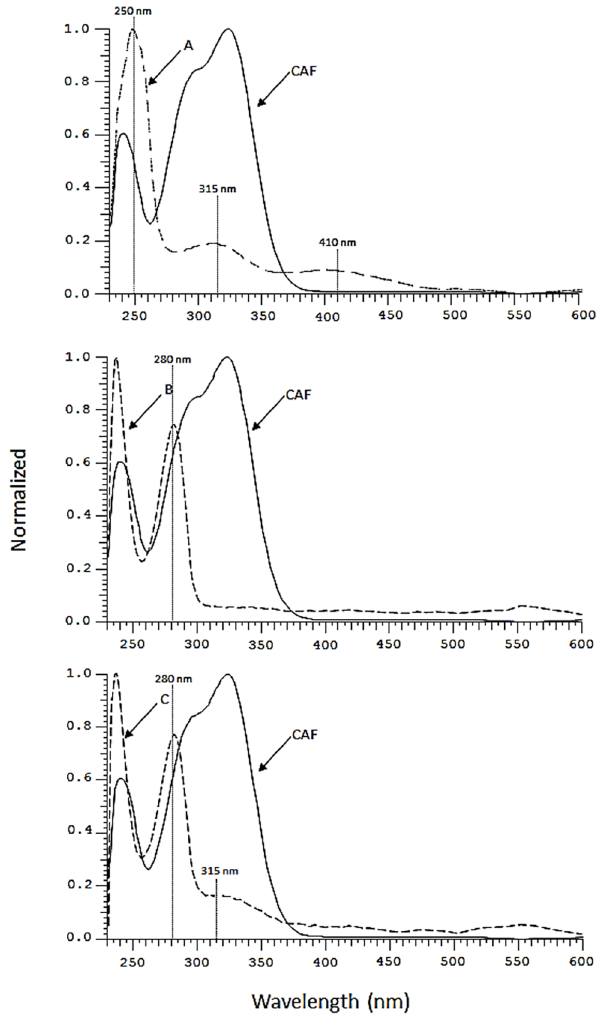
Fig 4. UV-Vis spectra of CAF (solid lines) and CAF-oxidation products (dashed lines, products A, B and C) recovered from the V(V)-CAF system at pH 2.8 after different reaction times, i.e. product A: 30 min, product B and C 24